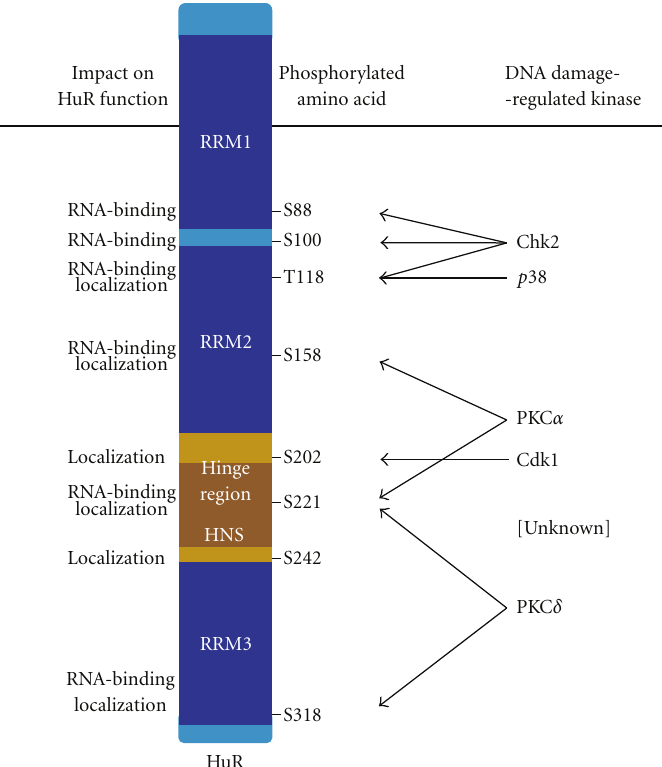
Figure 1: Sites of HuR phosphorylation by DNA damage-inducible kinases. Schematic of HuR depicting the RNA recognition motifs (RRMs, dark blue), the hinge region (brown) with the HuR nucleocytoplasmic shuttling sequence (HNS), the sites of phosphorylation (under “Phosphorylated Amino Acids”), and the DNA Damage-Regulated Kinases responsible, including an unknown kinase predicted to phosphorylate S242. The consequences of HuR phosphorylation at the di ff erent sites are indicated under “Impact on HuR Function”. More details in the